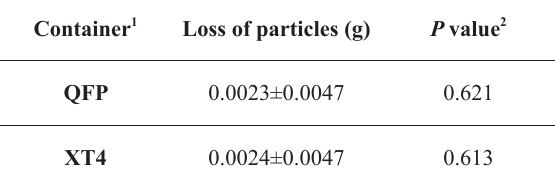
Estimates of the loss of particles in forages and cattle feces according to the different